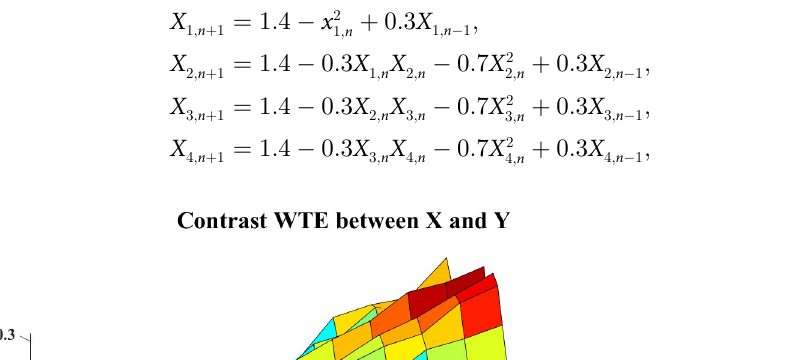
and coupling strength i